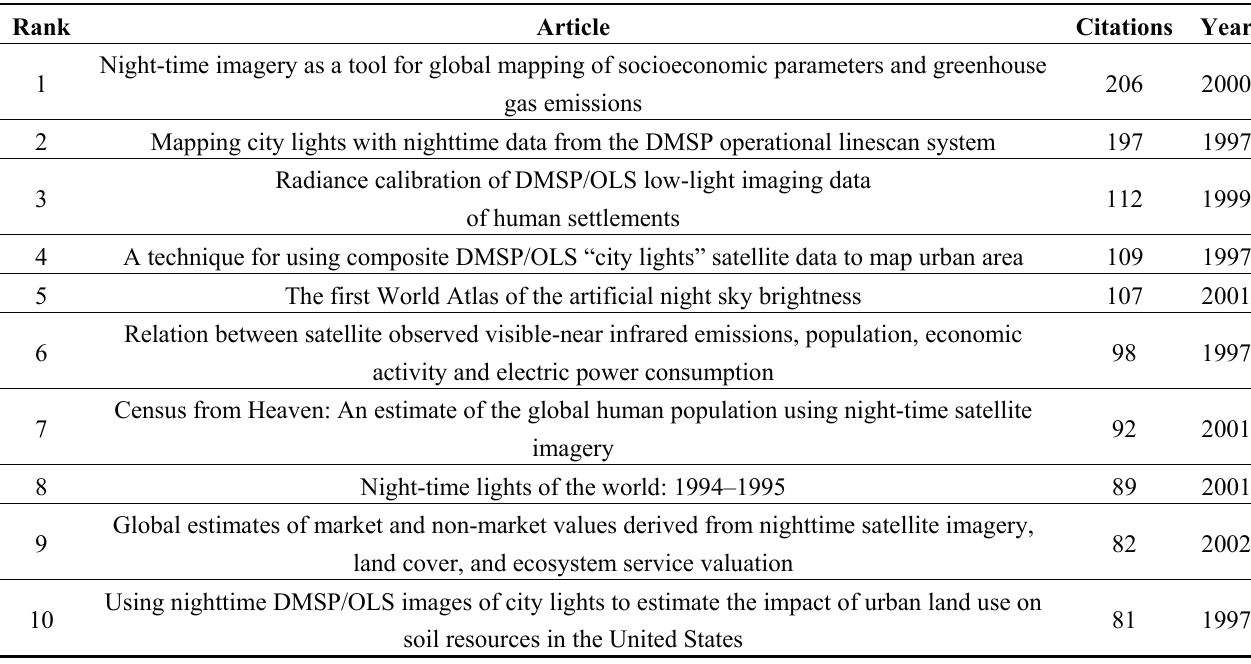
Table 5. Top 10 most-cited